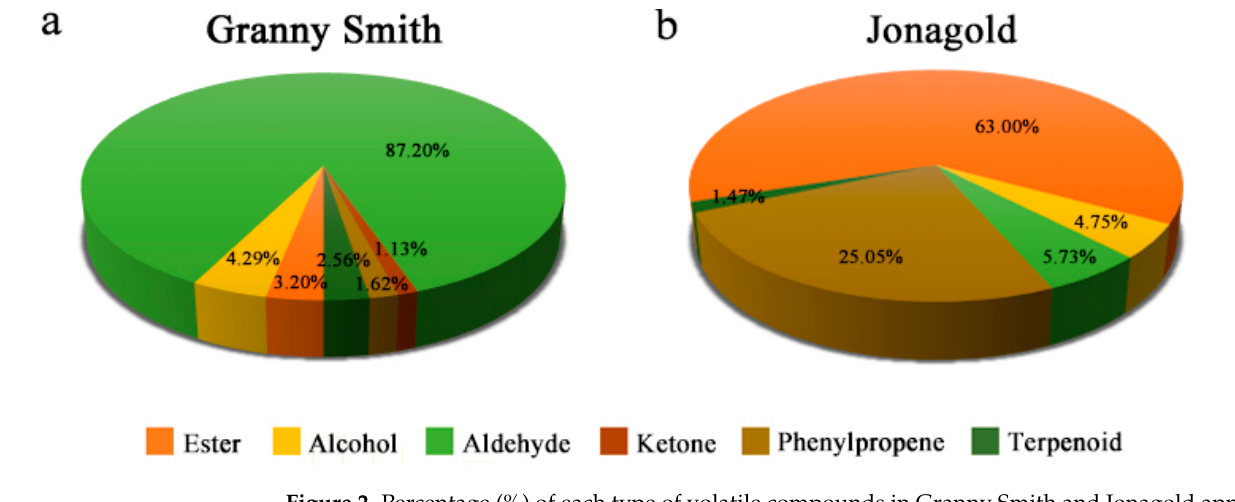
Figure 2. Figure 2. Percentage (%) of each type of volatile compounds in Granny Smith and Jonagold apples. ( a ) Volatile compounds in Granny Smith. ( b ) Volatile compounds in